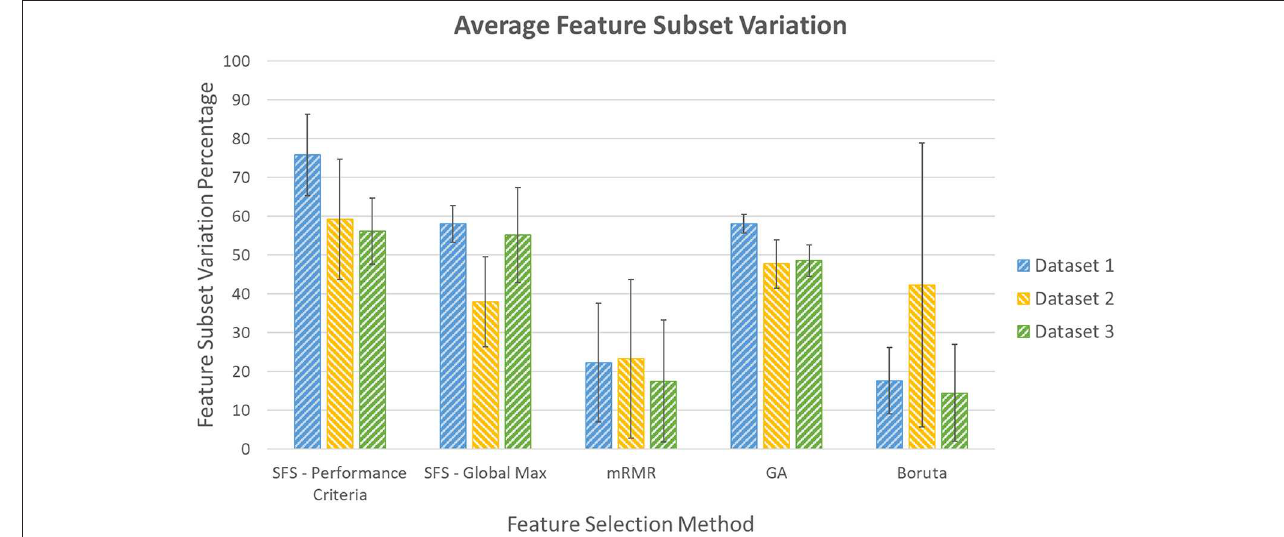
FIGURE 9 | Percentage variation in feature subsets as amount of training data were decreased.